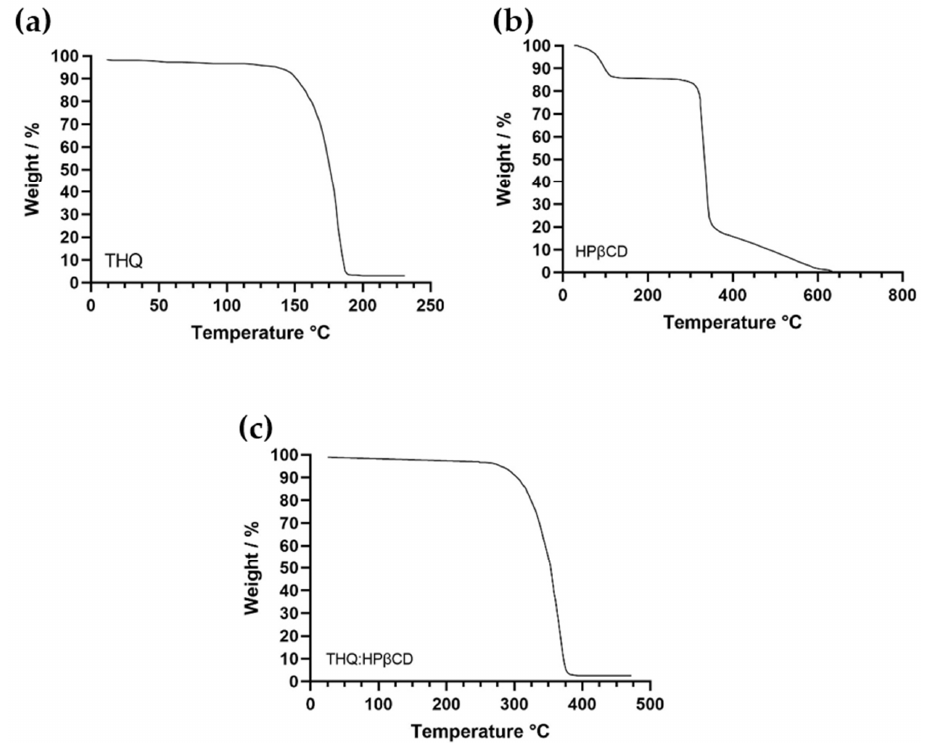
Figure 1. ( a – c ). Thermogravimetric analysis (TGA) of controls ( a ) THQ, ( b ) HPβCD, and sample THQ:HPβCD-IC ( c ) showing the thermal stability. TGA analysis of HPβCD and THQ:HPβCD was also performed. TGA results from control studies revealed that THQ is thermally stable up to 150 °C (Figure 1a), while HPβCD was stable up to 300 °C. TGA thermograms for all samples (Figure 1a–c) demon- strated 2-step thermal degradation process. The first minimal weight loss (%) in differen- tial thermograms was attributed to the trapped moisture. The second weight loss (%) is major which was reveled in the form a dip representing thermal degradation of samples. These results are in accordance with literature and our previously reported finding [20,33]. The results revealed that the complexation of the two components (THQ and HPβCD) reduced the thermal stability of HPβCD by 6.9%, however, increased the overall stability of THQ by 60.47%. This coincides with available data from previous studies in- vestigating TGA of THQ and HPβCD, with thermal degradation of the compounds show- ing a reduction at 213 °C and 300 °C, respectively [41–45]. Forced degradation studies were performed according to the above method. Ob- tained chromatograms were compared to a fresh reference sample prepared at room tem- perature (Figure 2). The thymoquinone eluted at the 4 min retention time irrespective of degradation time and no impurity peaks were observed confirming that THQ is thermally